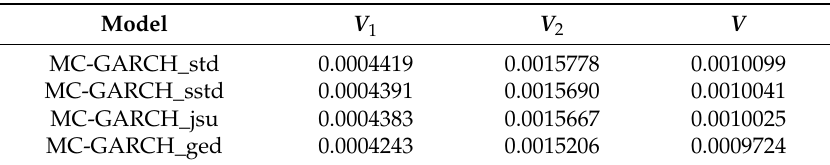
Table 10. Intraday ES Forecast: V-tests Backtesting